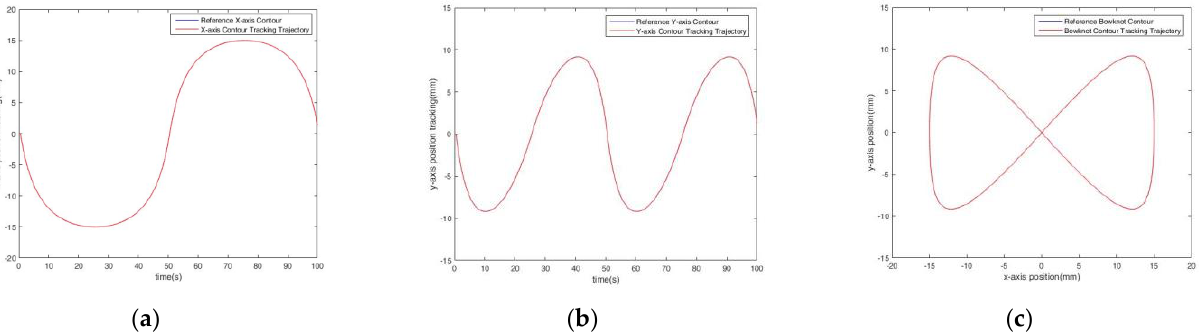
Figure 8. The path trajectory of the simulations. ( a ) The X − axis tracking response, ( b ) the Y − axis tracking response, ( c ) the bowknot path response.